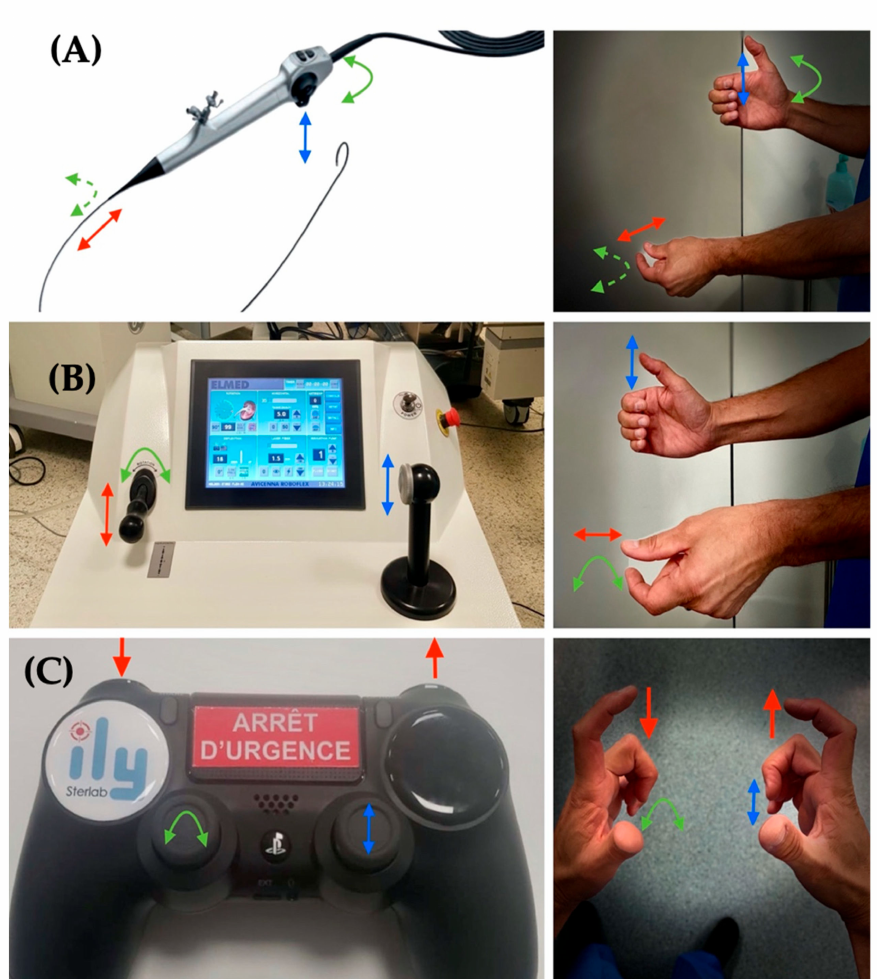
Figure 6. Placement of surgeon’s hands and movements to manipulate ( A ): Flexible ureteroreno- scope; ( B ): Avicenna robot; ( C ): ILY ® robot. Arrows represent how to perform different movements. Avicenna tries to reproduce hand movements, while ILY ® changes completely the concept of using a video-game controller. Arrows indicate directions of hands, fingers, scope and